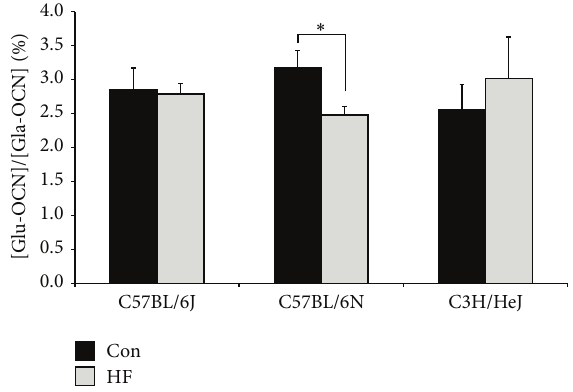
Figure 4: Plasma osteocalcin (OCN) expressed as percent of under- carboxylated Glu-OCN per total Gla-OCN in C57BL/6J, C57BL/6N, and C3H/HeJ mice on a control (Con; AIN-93M) or a high fat diet (HF; 45% kcal from fat) after 24 wk. Symbol, ∗ , represents a significant difference ( 𝑃 < 0.05 ) between dietary treatments for a given